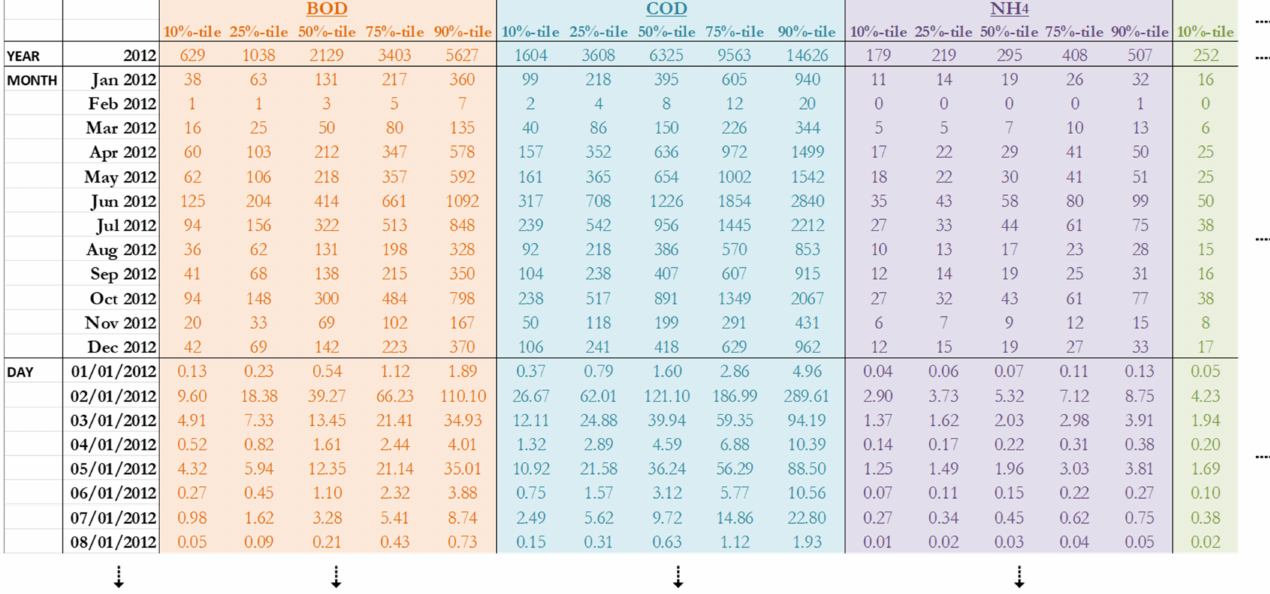
Figure 8. Cockle output: predicted emitted loads on a daily, monthly, and yearly basis for each pollutant following percentile for one CSO (partly shown